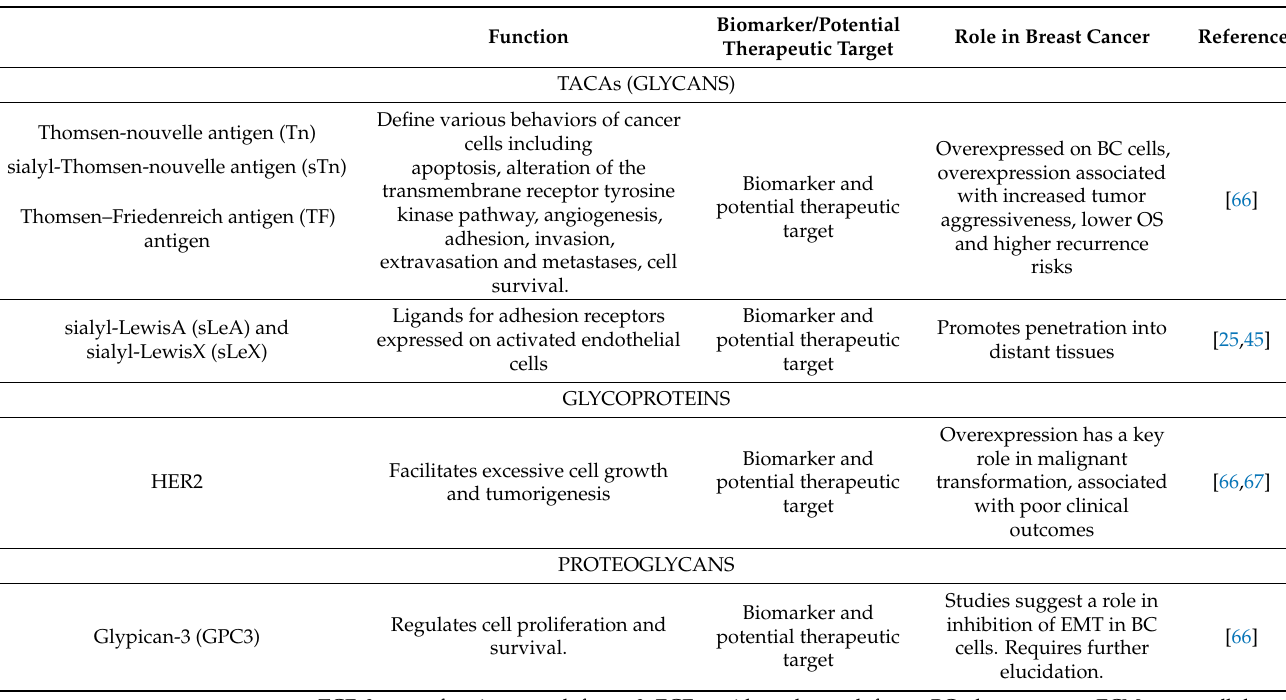
Role in Breast Cancer Reference